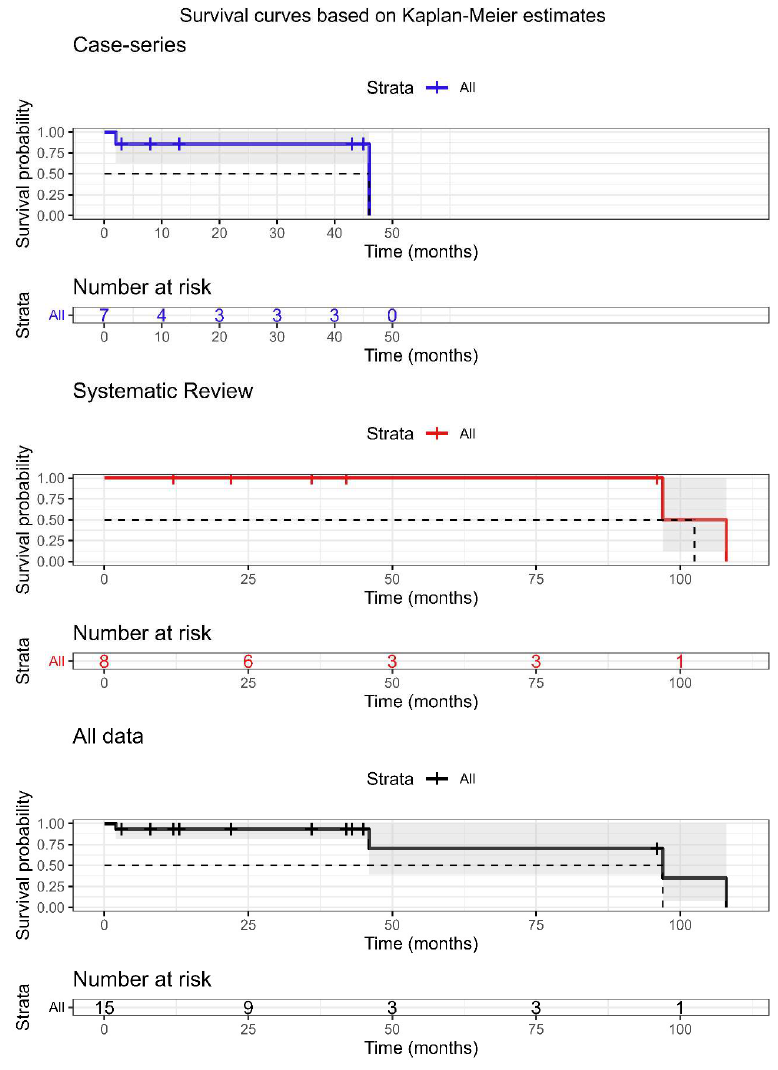
Figure 2. Survival analysis of patient with bone metastasis by LMS based on Kaplan–Meier estimates for the case series ( n = 7), systematic review series ( n = 8), and all data ( n = 15). Cases with unknown follow-up outcomes or survival times were excluded from the analysis.